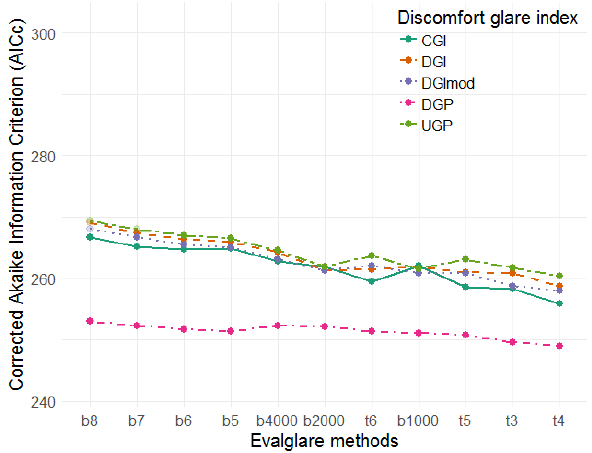
Figure 8. Comparison of Akaike’s Information Criterion (AICc) for each discomfort glare index between the studied evalglare methods (field study).